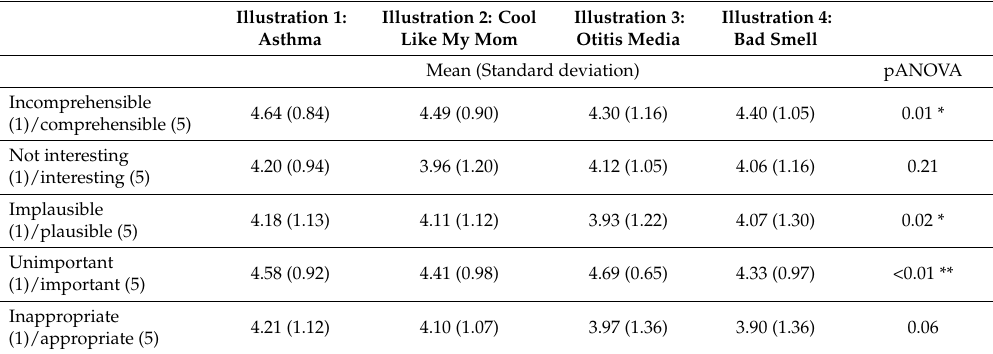
Table 2. Evaluation of the quality of the illustrations and their key messages by the 121 participants in the quantitative